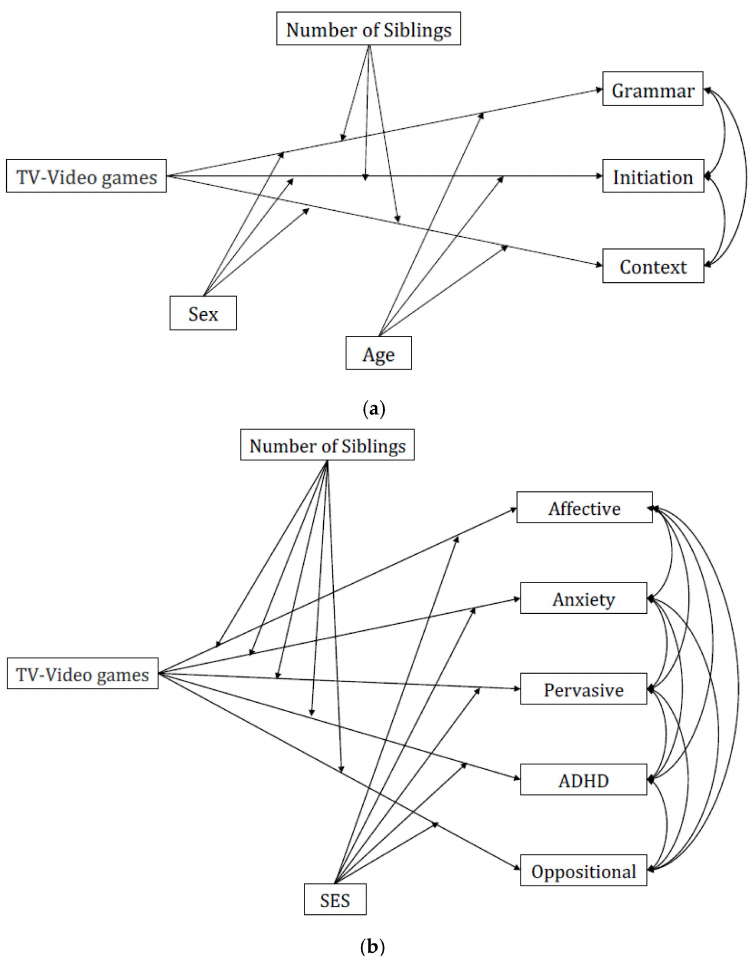
Figure 1. ( a ) The multiple-moderator model for language skills: TV–Video games = average score between watching TV and playing video games; language skills as defined by the PCA, including Speech, Syntax, Semantics, Initiation, and Context. ( b ) The multiple-moderator model for emotional– behavioral profiles: TV–Video games = average score between watching TV and playing video games; SES as defined by the PCA, including maternal and paternal educational level and